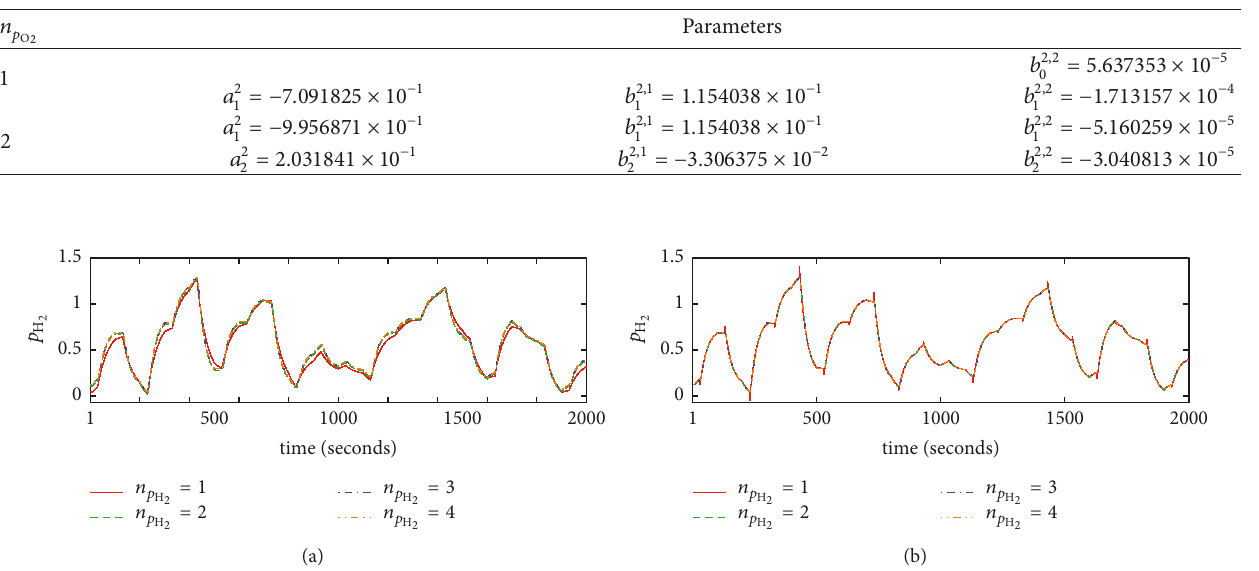
Figure 5: The hydrogen pressure trajectories calculated by reduced order ( 𝑛 𝑝 algorithm 1 (a) and algorithm 2